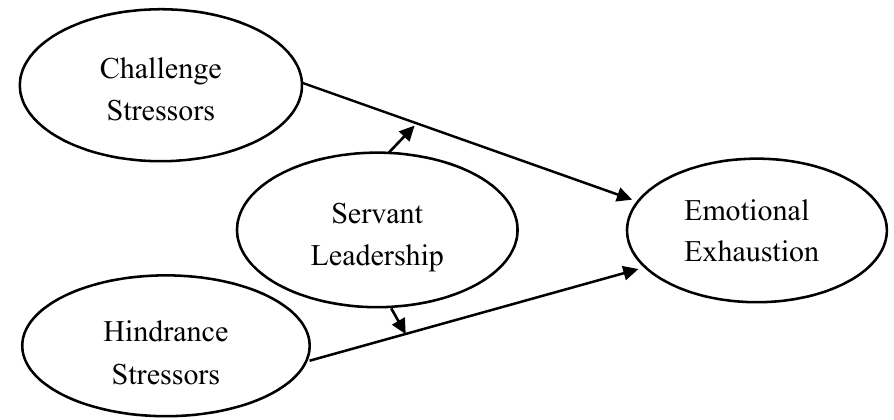
Figure 1. Hypothesized conceptual model.